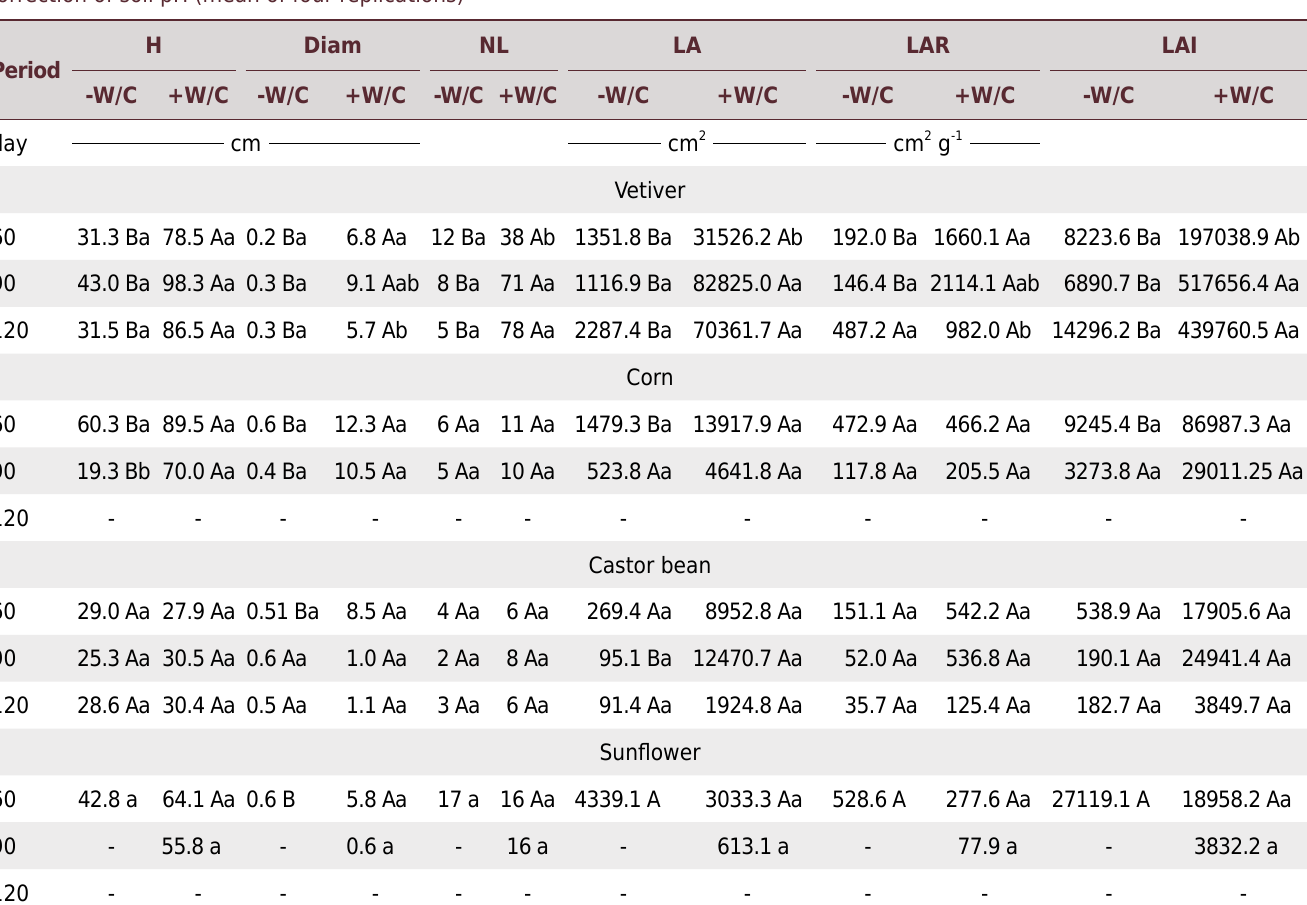
Means followed by the same letter, uppercase letters for lines and lowercase letters for columns, within characteristics evaluated for each species, do not differ among themselves by the Tukey test